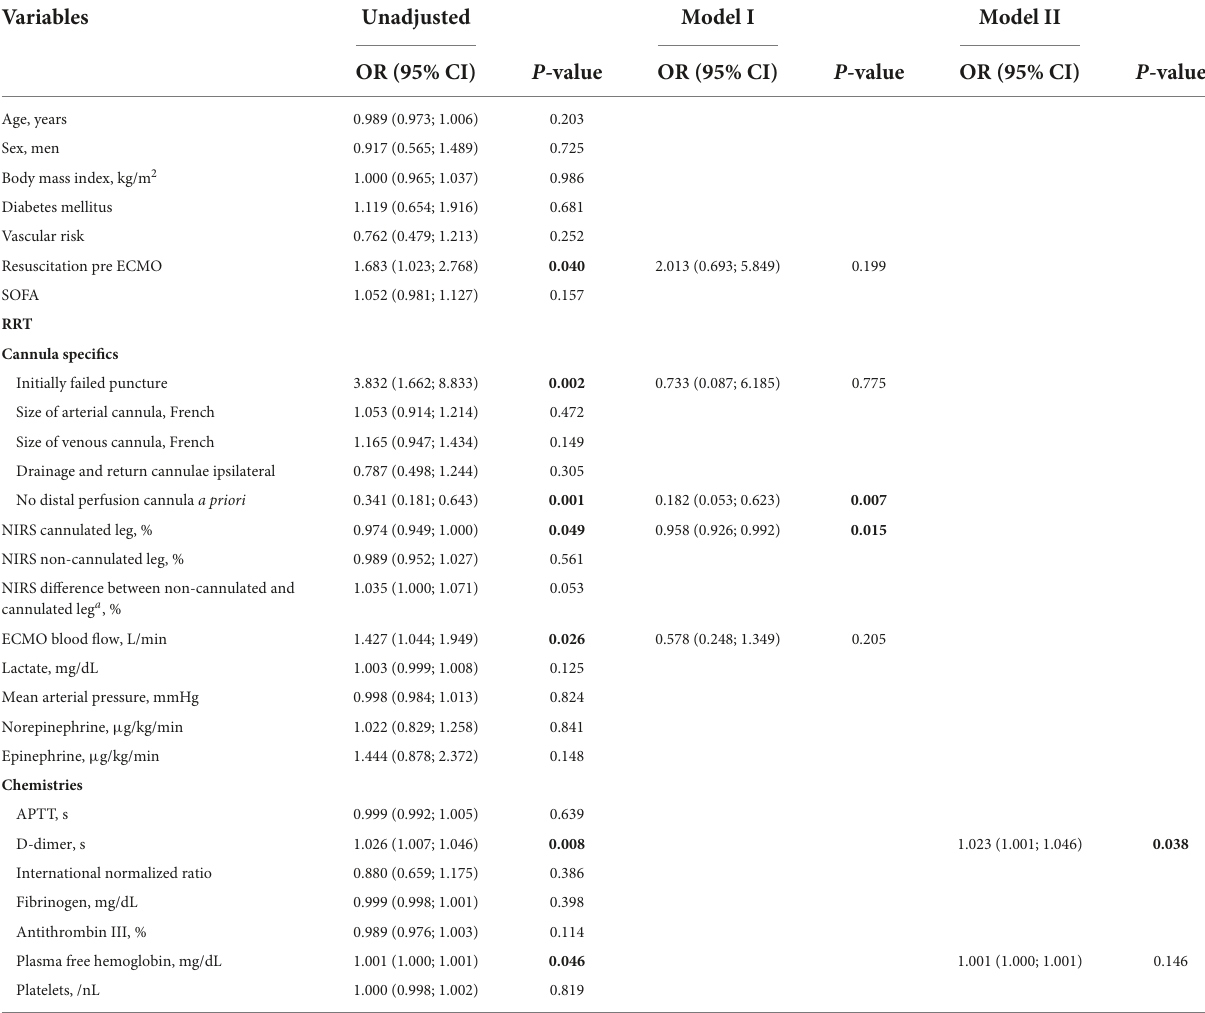
TABLE 4 Univariate and multivariate binary logistic regression models for limb ischemia at the time of cannulation in survivors of veno-arterial extracorporeal membrane